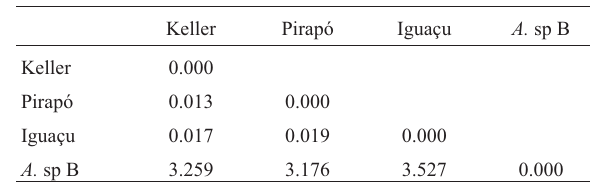
Table I - Genetic distances of Tamura and Nei (1993) based on mito- condrial control region sequences, with gamma distribution, among Astyanax altiparanae individuals from Iguaçu River and from the Keller and Pirapó tributaries of the Upper Paraná River basin, and Astyanax sp B individuals from the Iguaçu River.